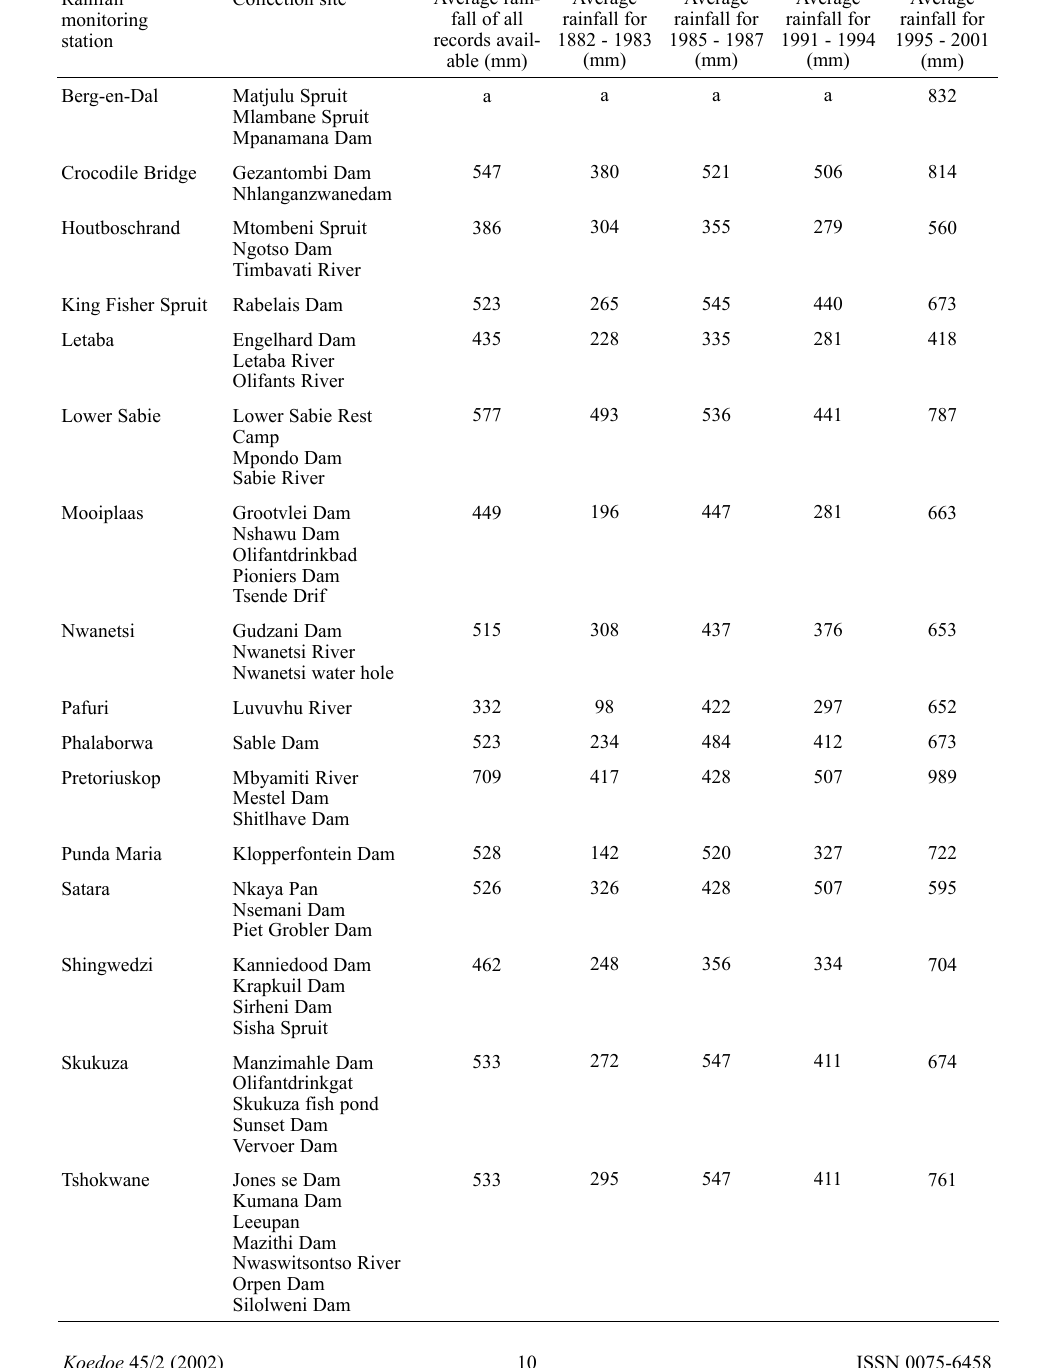
Table 4 Rainfall records of the Kruger National Park at the different monitoring stations nearest to collection sites over different time